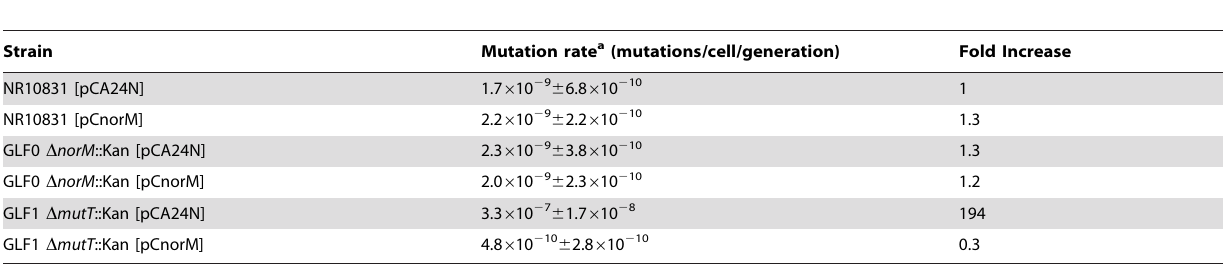
Table 2. Spontaneous Lac 2 to Lac + mutation rates of the wild-type, D mutT and D norM derivatives containing the empty vector or the norM -encoding plasmid.